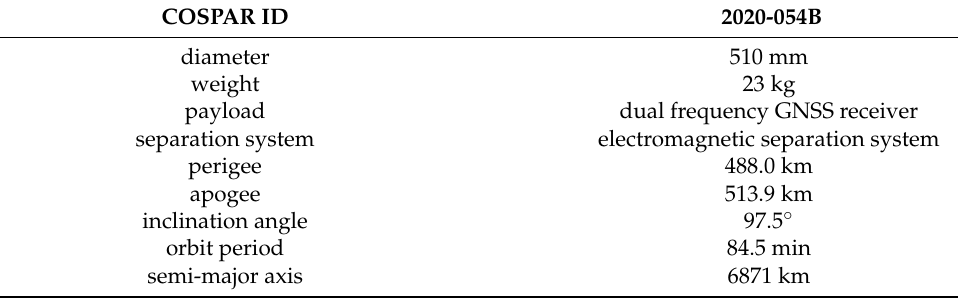
Table 1. Q-SAT Specifications.